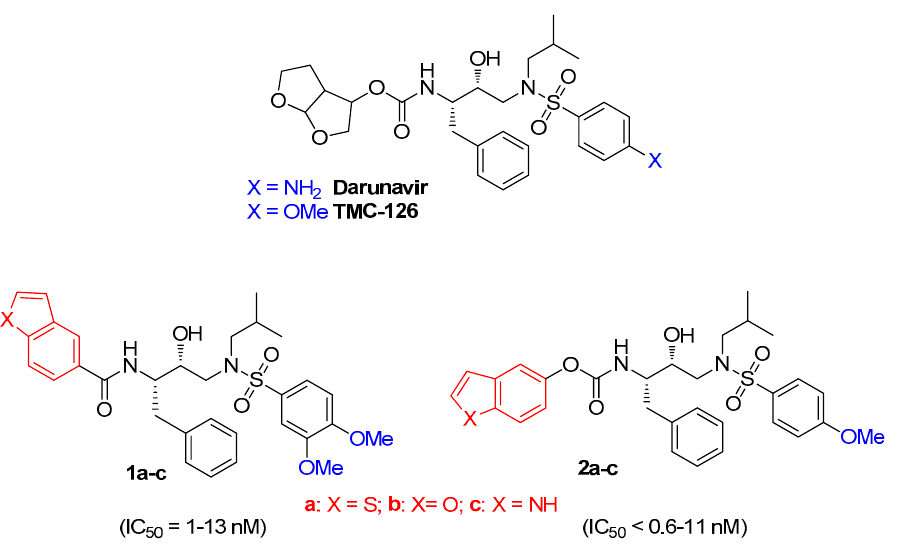
Figure 1. Commercial and not HIV-protease inhibitors.